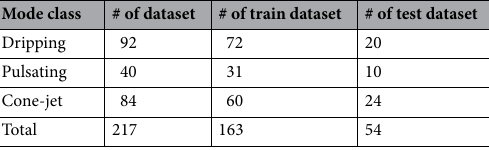
Table 1. The number of datasets for electrospray mode